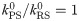
Motor properties in the high MT affinity regime with kPS0/kRS0=1.(A) The average motor displacement per hydrolysis of one ATP molecule of an unloaded motor as a function of the kinetic rate k-MT0 for different values of the asymmetry parameter. (B) The force–velocity diagram for two values of the kinetic rate k-MT0, k-MT0/(kRS0+kPS0)=0.001 (blue) or 0.01 (red). (C) The stall force as a function of k-MT0/(kRS0+kPS0). (D) The force dependence of the work produced by the motor for parameters as in (B). In all plots δa/δ¯=0.1 (dotted line), 0.33 (dashed line), and 1.0 (solid line).